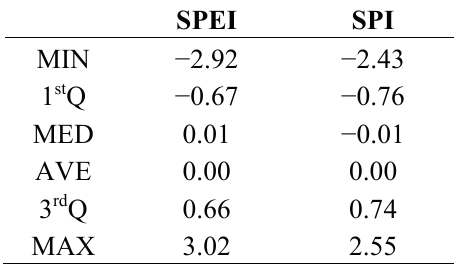
Table 8. Summary statistics for three-month time scale SPEI and SPI over 1919 to